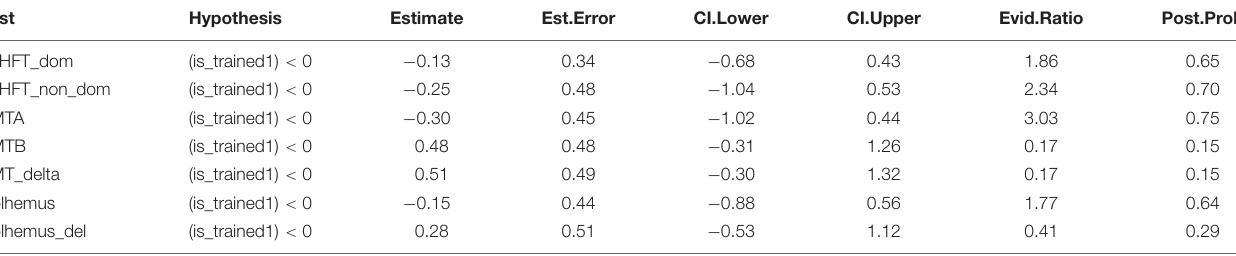
TABLE 1 | Hypothesis tests for the effect of training.